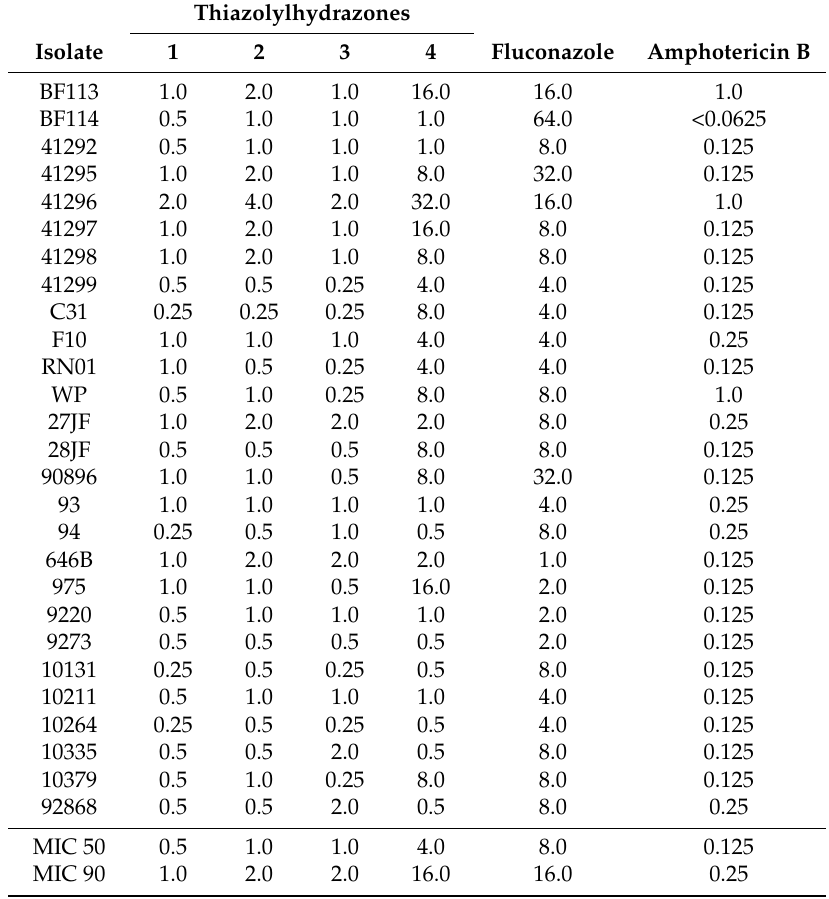
Table 5. MIC * of thiazolylhydrazones compounds against Cryptococcus neoformans clinical